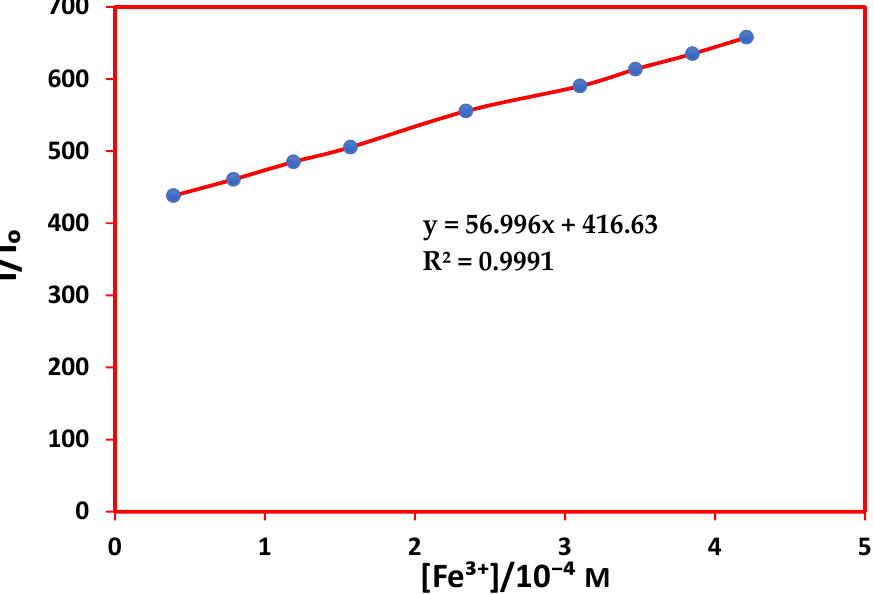
Figure 10. Stern-Volmer plot for titration of SBA-Pr-Is-TAP with different concentrations of Fe 3+ . Table 2. Comparison of Detection Limits of different fluorescent Fluorescence studies of SBA-Pr-Is-TAP after adding di ff erent anions A ⁿ⁻ , including = I - , CN - , Cl - , F - , Br - , CO 32- , SO 42- , HCO 3- , H 2 PO 4- , NO 2- , NO 3- , CH 3 COO - , SCN - , S 2 O 32- , OH - , and Cr ₂ O ₇ ² ⁻ , was obtained at λ ex = 220 nm, λ em = 420 nm as shown in Figure 11 and Scheme 3. Luminescence intensities were in fl uenced by adding Cr ₂ O ₇ ² ⁻ ions as compared to other anions. Therefore, SBA-Pr-Is-TAP also showed a potential recognition and sensing for Cr ₂ O ₇ ² ⁻ ions.